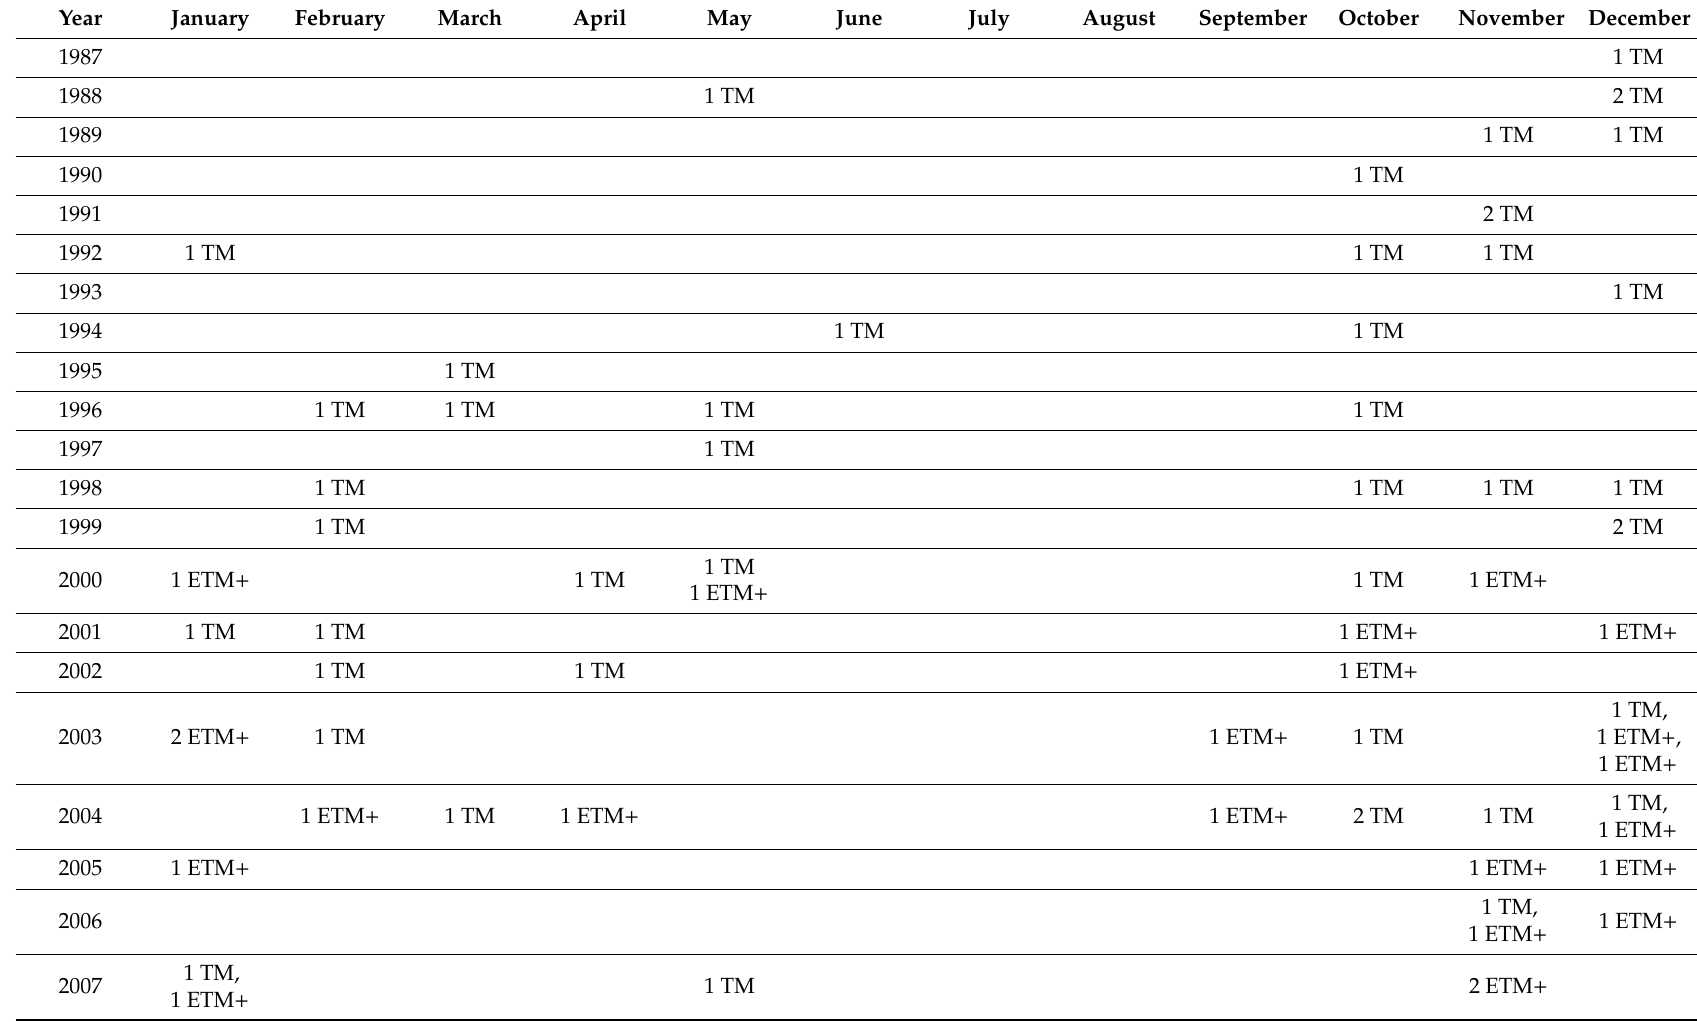
Table 1. Landsat Level 2 imagery acquired for tree line extraction in Wuyishan National